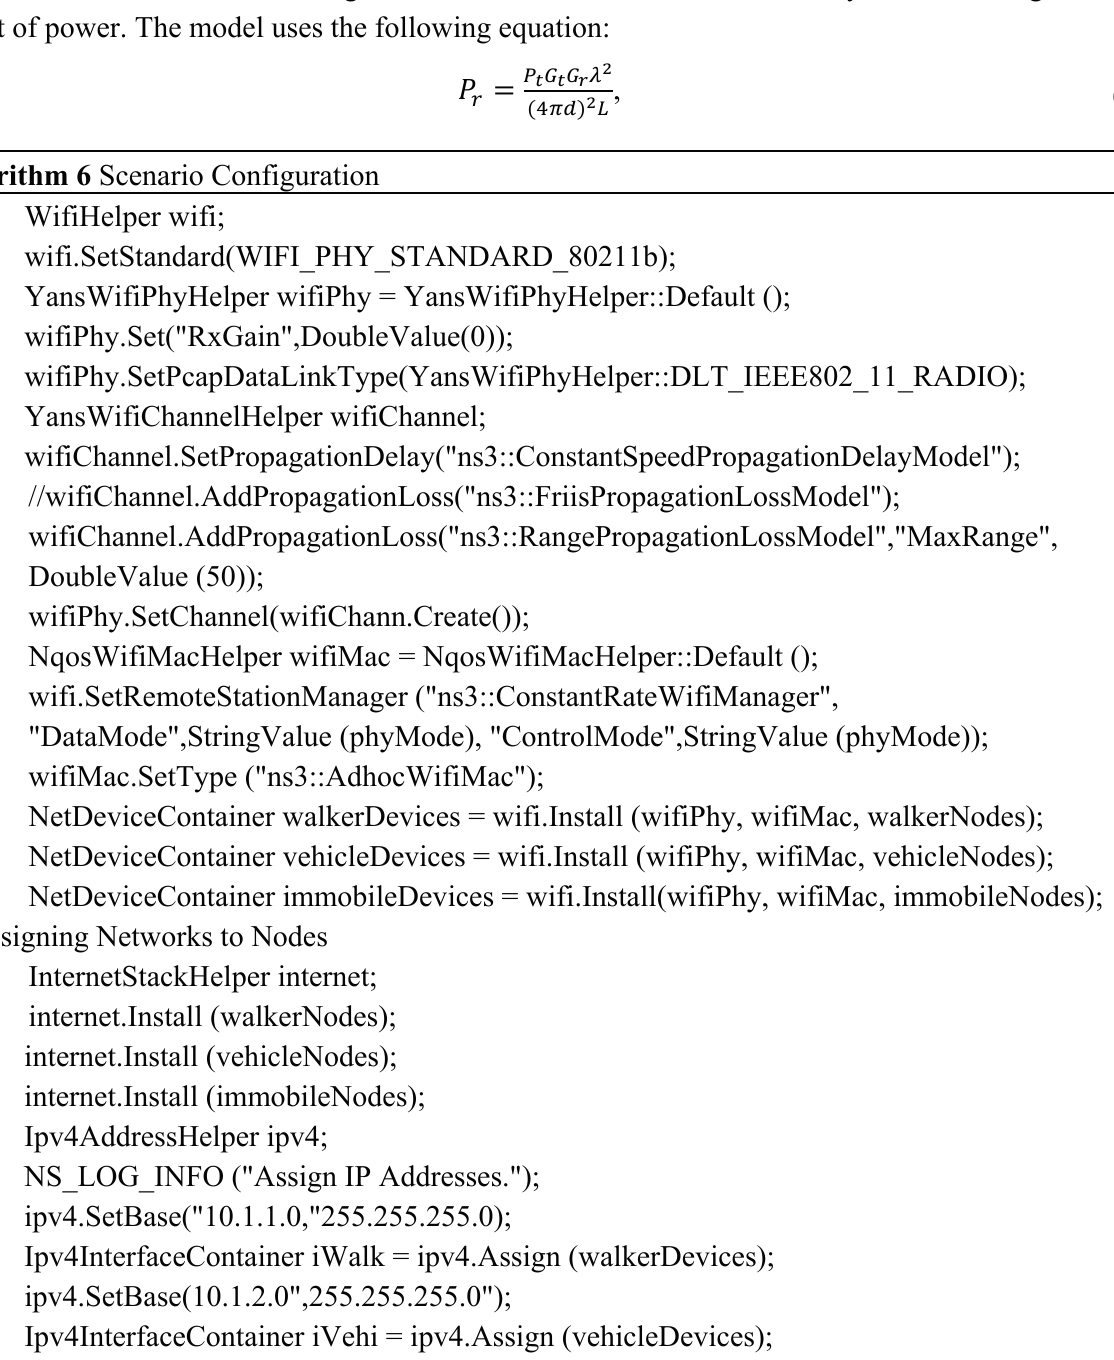
Algorithm 6 Scenario